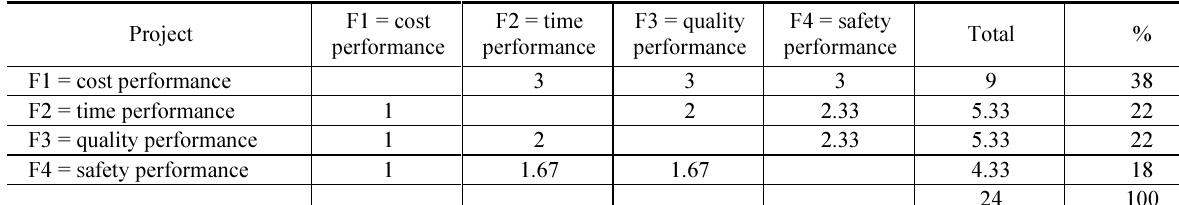
Table 1 . Determination of criteria weight